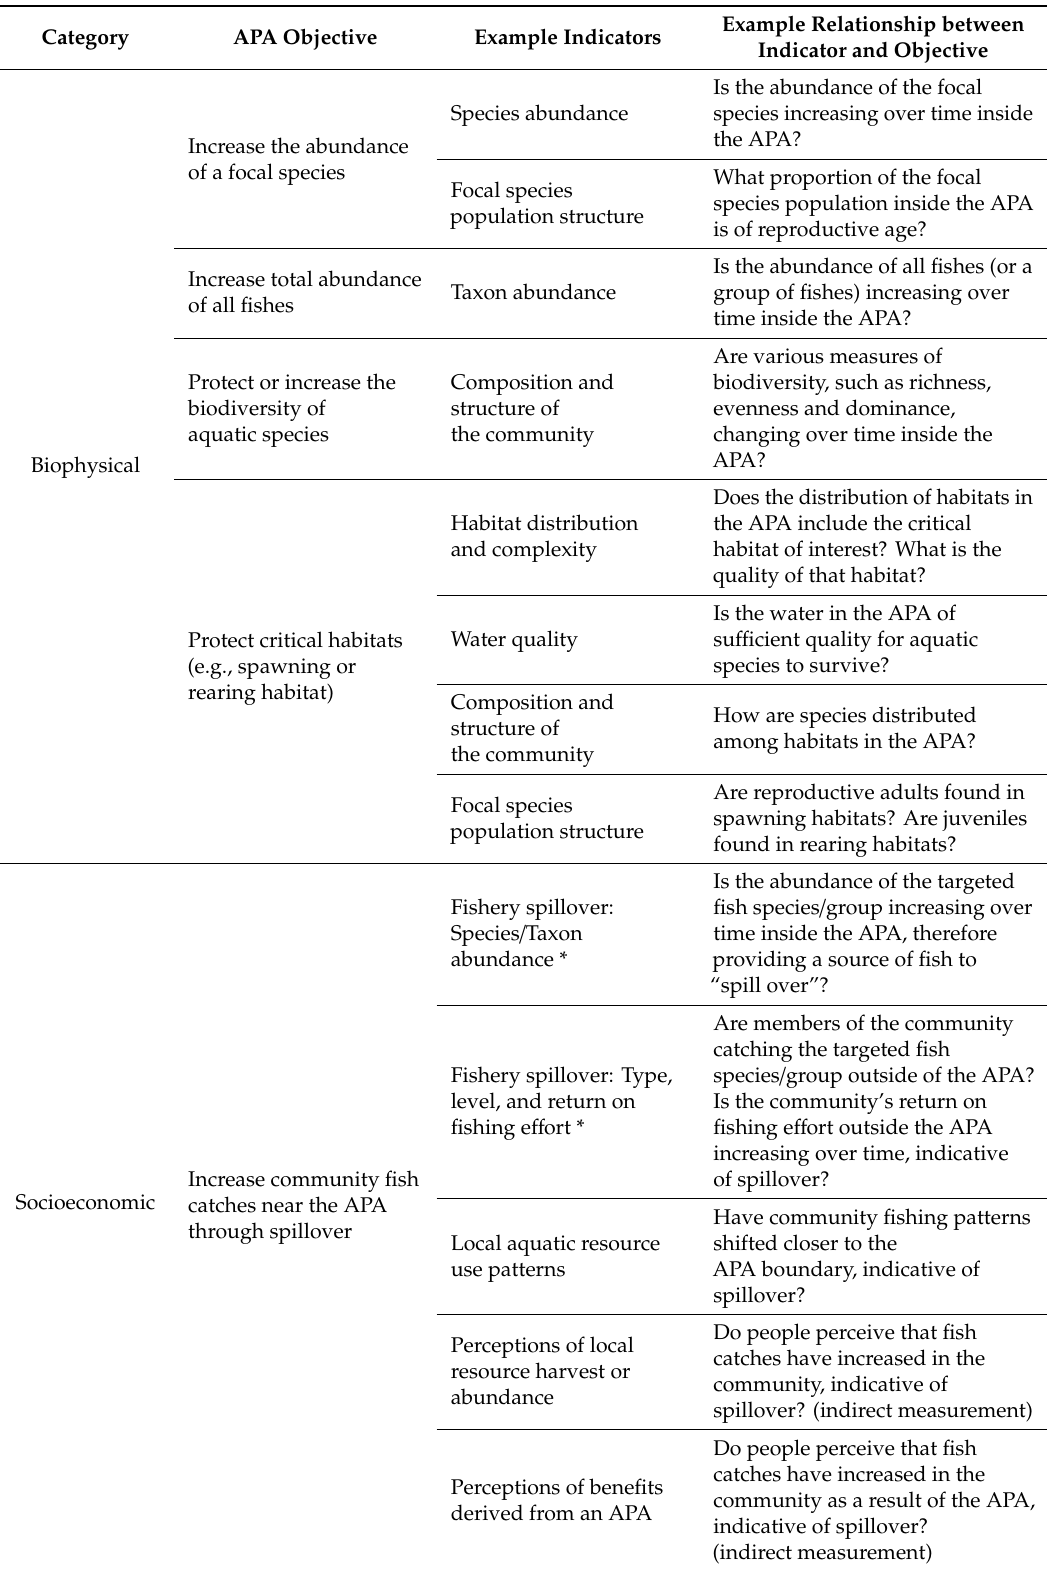
Table 1. List of performance indicators linked to common Aquatic Protected Area